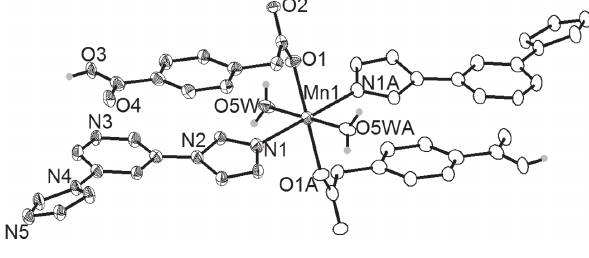
Table 1: Data collection and